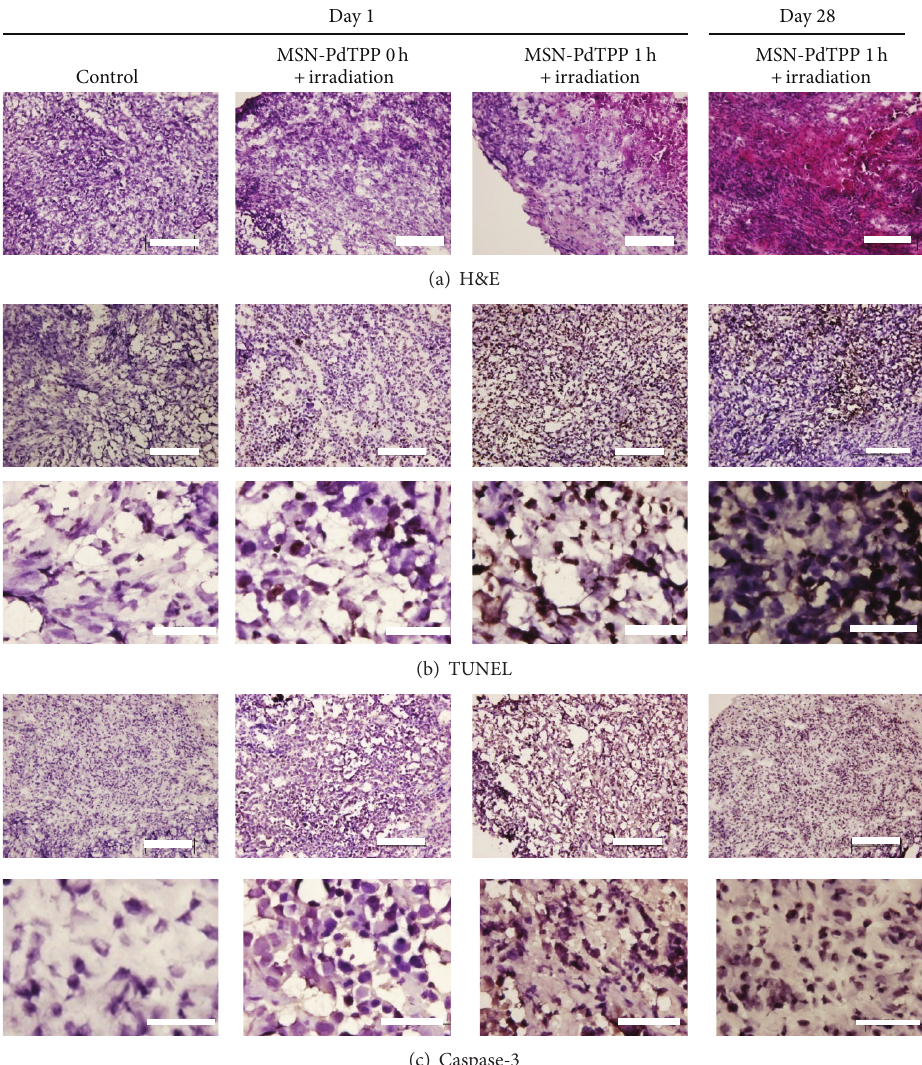
Figure 6: (a) Histological staining of the excised tumor sections on treatment day 1 of (i) saline with no photoirradiation (control), (ii) MSN- PdTPP with photoirradiation at 0h after injection, (iii) MSN-PdTPP with photoirradiation at 1h after injection, and on treatment day 28 of (iv) MSN-PdTPP with photoirradiation at 1h after injection. H&E staining; scale bars: 200 𝜇 m. (b) TUNEL staining of consecutive sections for each group at 200x magnification (upper, scale bars: 200 𝜇 m) and 1000x magnification (upper, scale bars: 50 𝜇 m). (c) Caspase-3